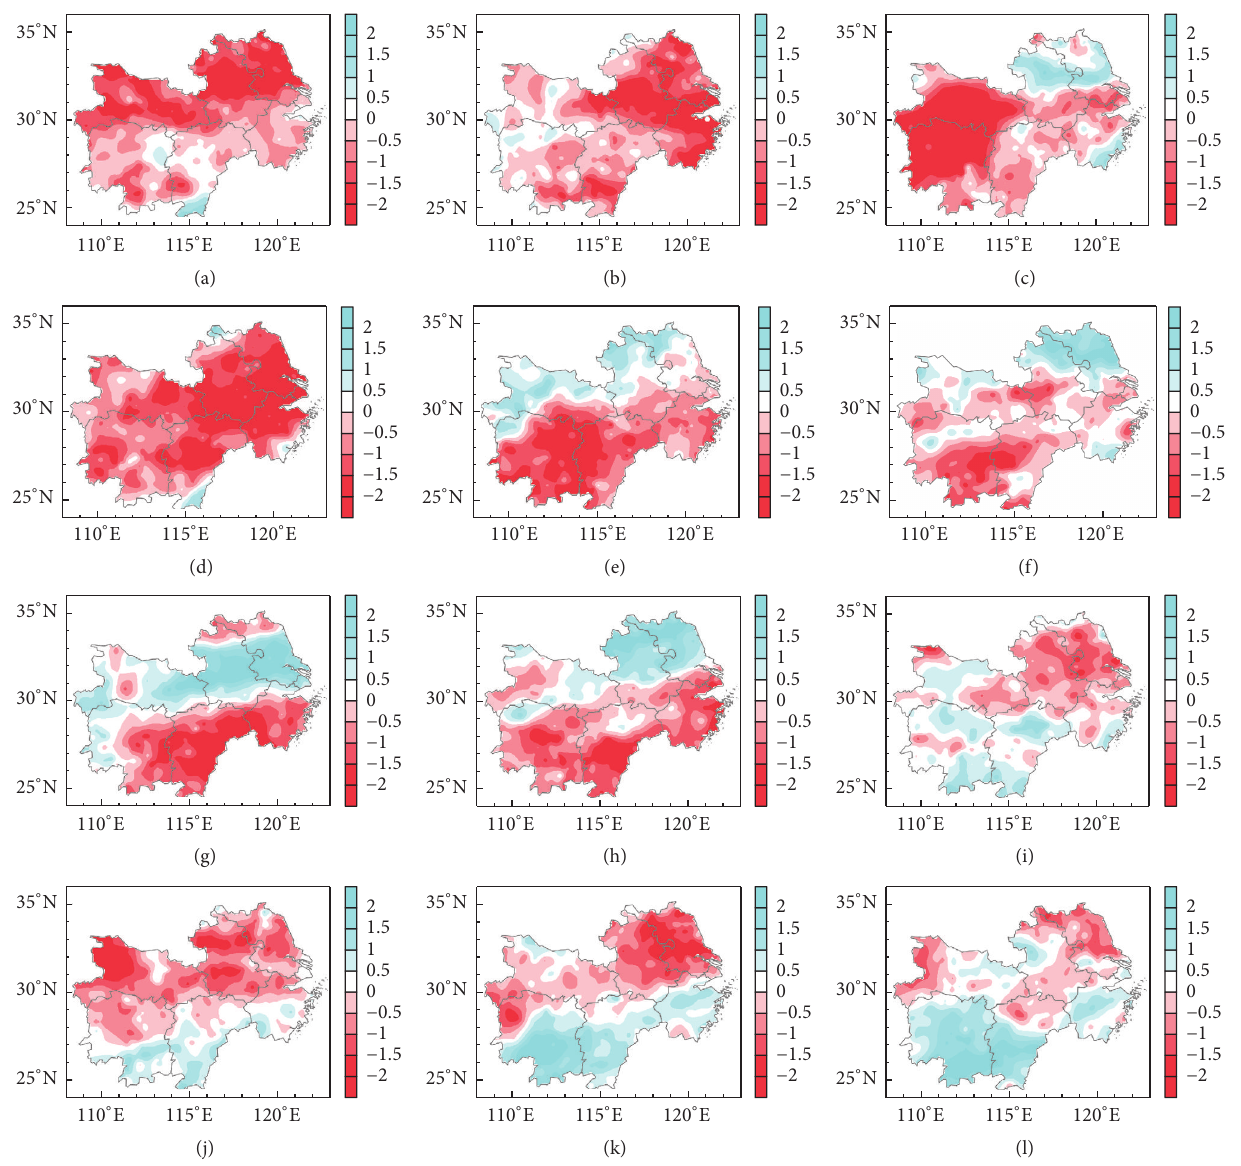
Figure 4: The distribution of the SPI3 for the typical drought years of the three drought patterns in the summers of (a) 1966, (b) 1967, (c) 1972, (d) 1978, (e) 1963, (f) 1965, (g) 1991, (h) 2003, (i) 1973, (j) 1976, (k) 1994, and (l) 2002. The positive values (blue) denote wet conditions, and the negative values (red) denote dry